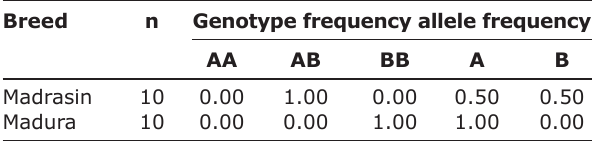
Table-1: Genotype frequencies and FSH gene alleles in Madrasin cattle (genotype and allele frequencies of Madrasin cattle). Breed n